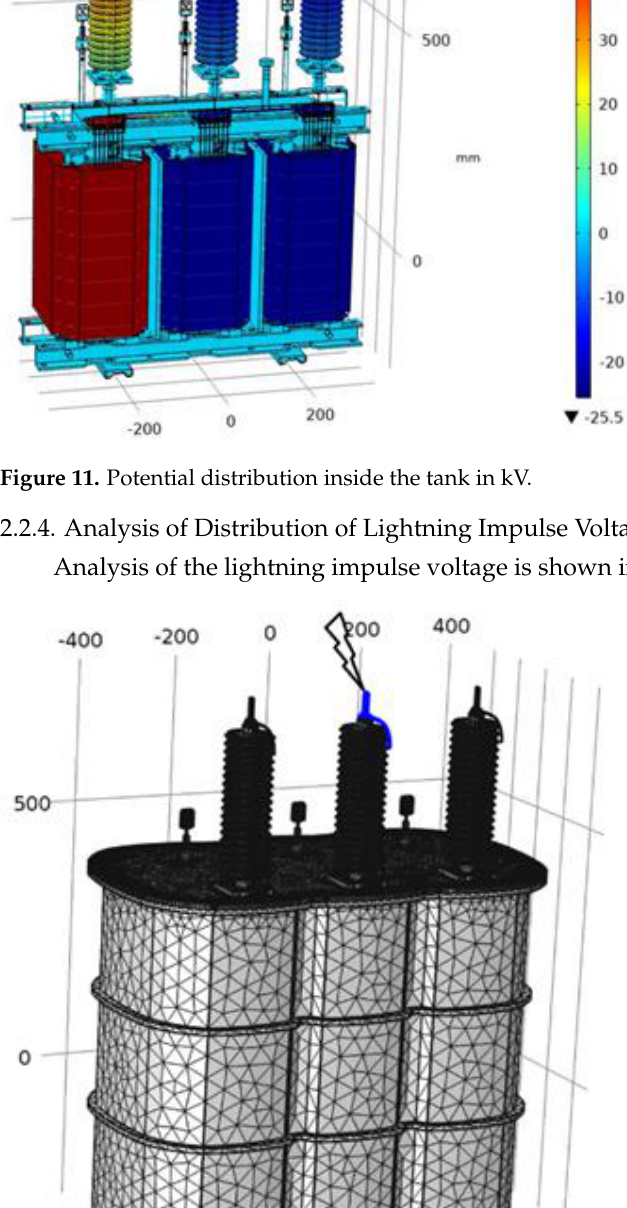
Figure 12. Transformer during lightning impulse during normal operation.